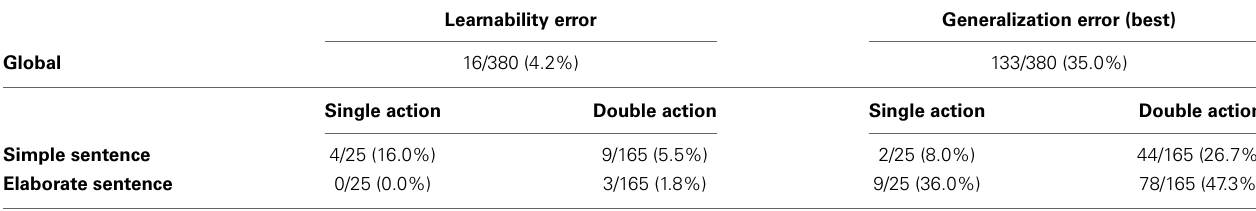
Table 5 | Learnability and best generalization capabilities on the naïve subject initial 380